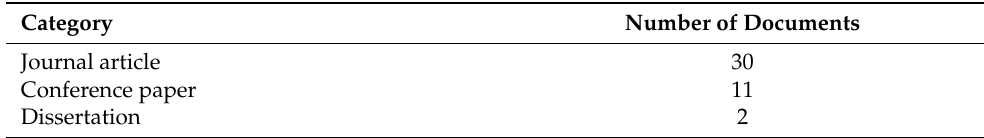
Table 3. Collected articles with human factor in the